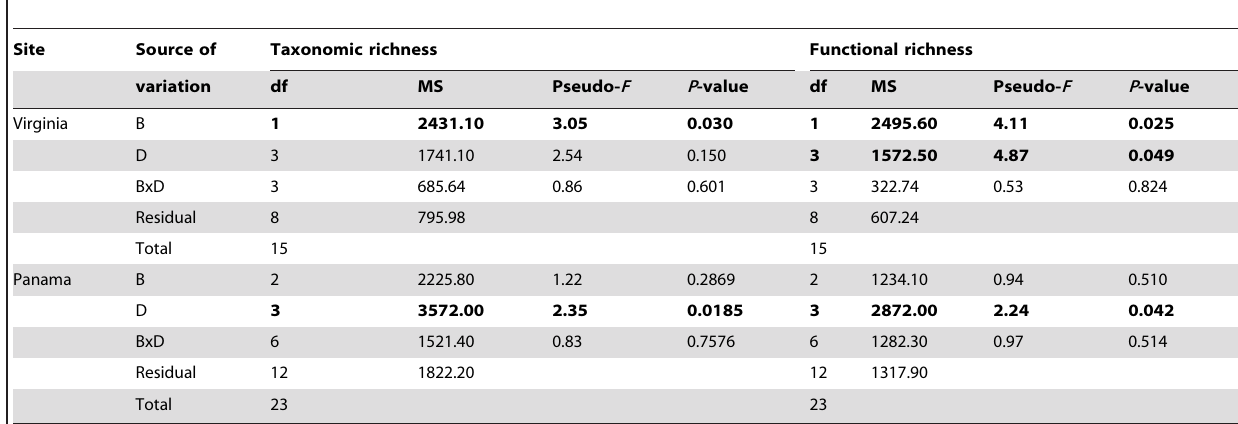
Table 4. Summary of the two-factor PERMANOVA of the multivariate